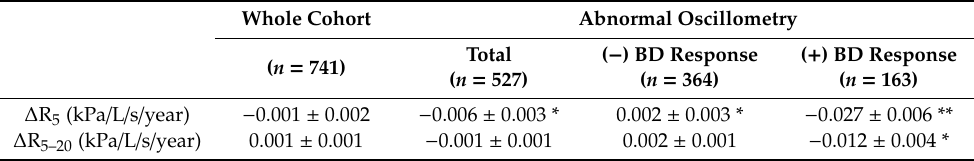
Table 4. Longitudinal change in oscillometry